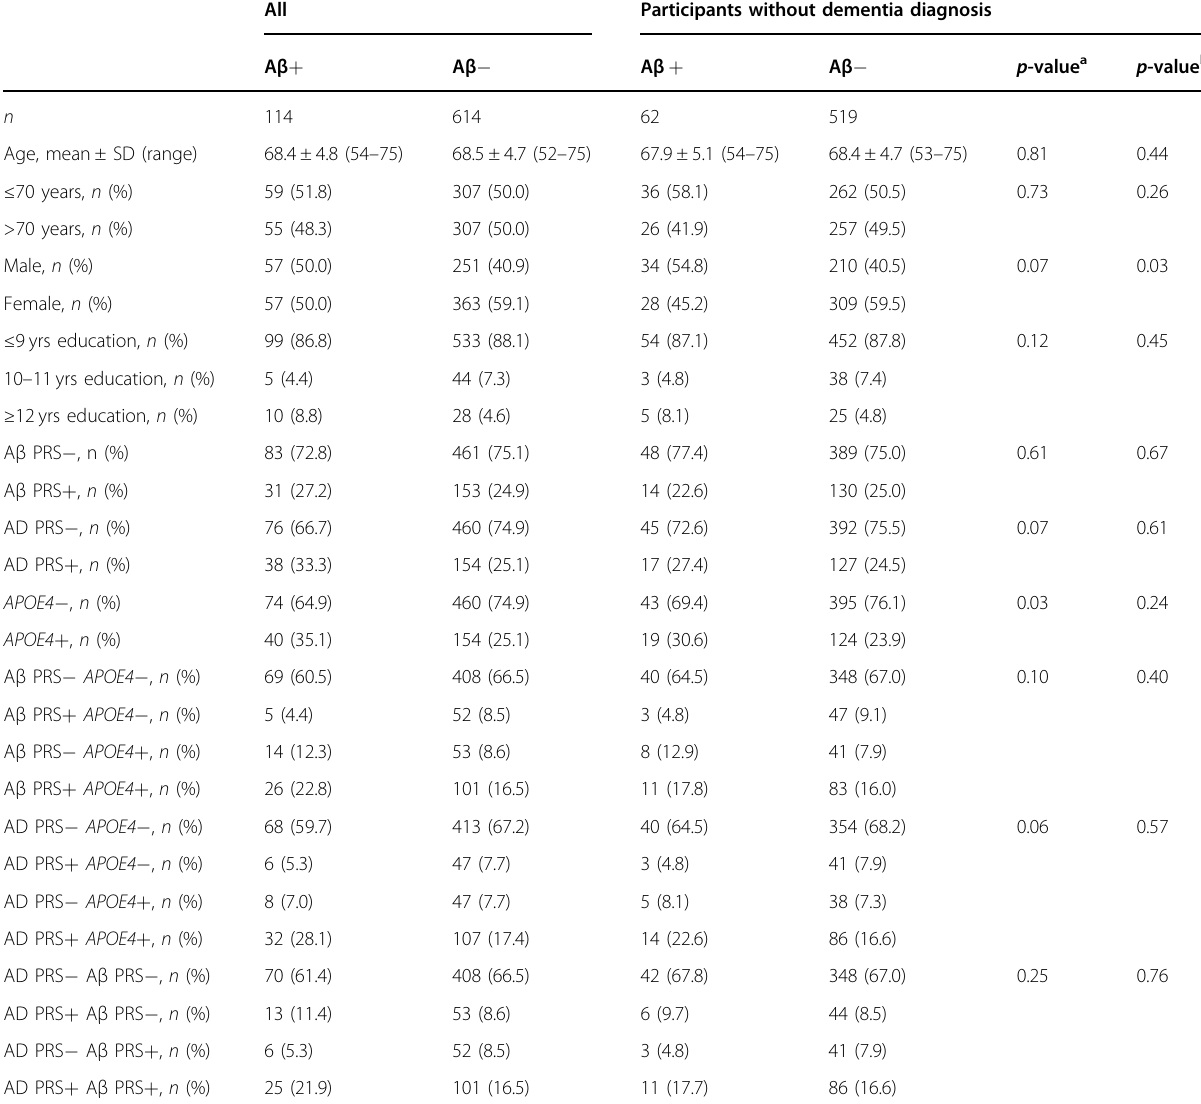
Table 1 Participant